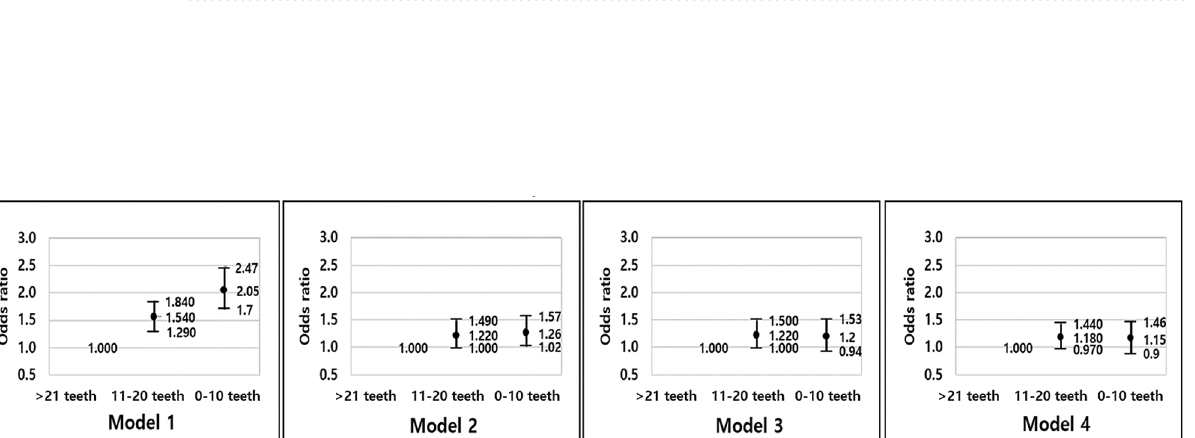
Table 3. Adjusted association between the number of existing permanent teeth and dietary calcium and potassium intake (within recommendation and below recommendation) (n = 6,356). The dependent variable was daily calcium and potassium intake. OR odds ratio, CI confidence interval. Below recommendation of calcium was < 700 mg, within recommendation of calcium was ≥ 700 mg. Below recommendation of potassium was < 3500 mg, within recommendation of potassium was ≥ 3500 mg. a Model 1 was unadjusted association. b Model 2 was adjusted for age, sex, household income and education. c Model 3 was adjusted for all variables in model 2 and use of floss, use of interproximal brush and periodontitis. d Model 4 was adjusted for all variables in model 3 and smoking status, alcohol consumption, hypertension, diabetes mellitus and obesity. Bold values denotes statistical significance at p < 0.05.